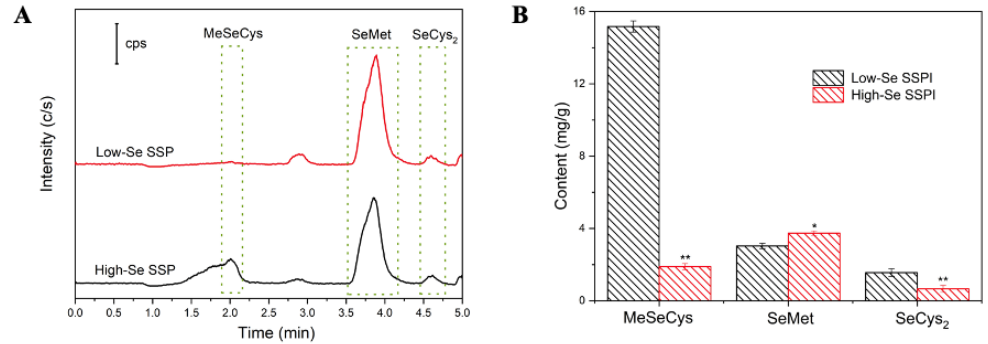
Figure 3. ( A ) HPLC-MS chromatograms of SSP samples. ( B ) Se species compositions in SSP samples. Values are means ± SDs ( n = 3). * represent p < 0.05 and ** represent p < 0.01.